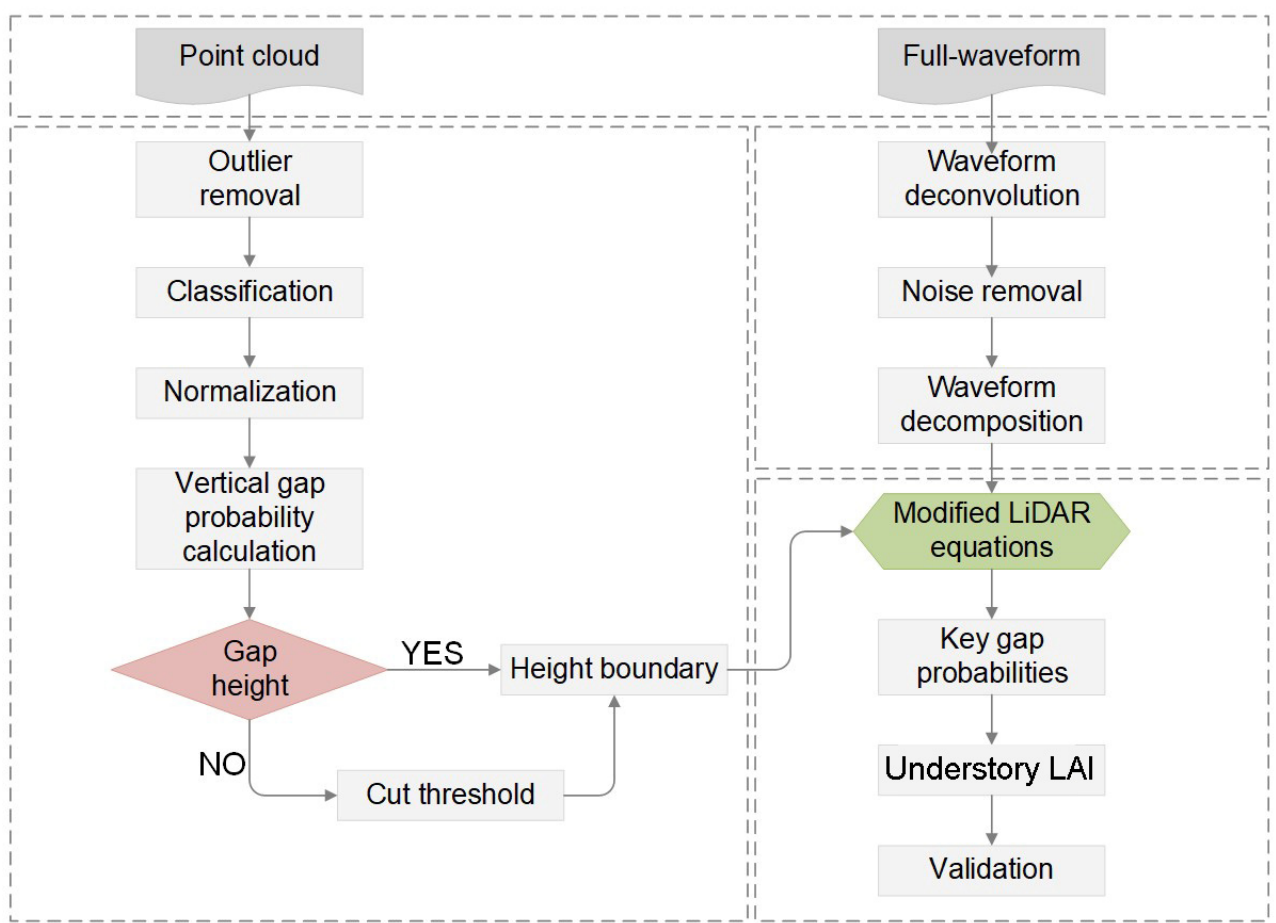
Figure 3. The main methodological workflow of this study.